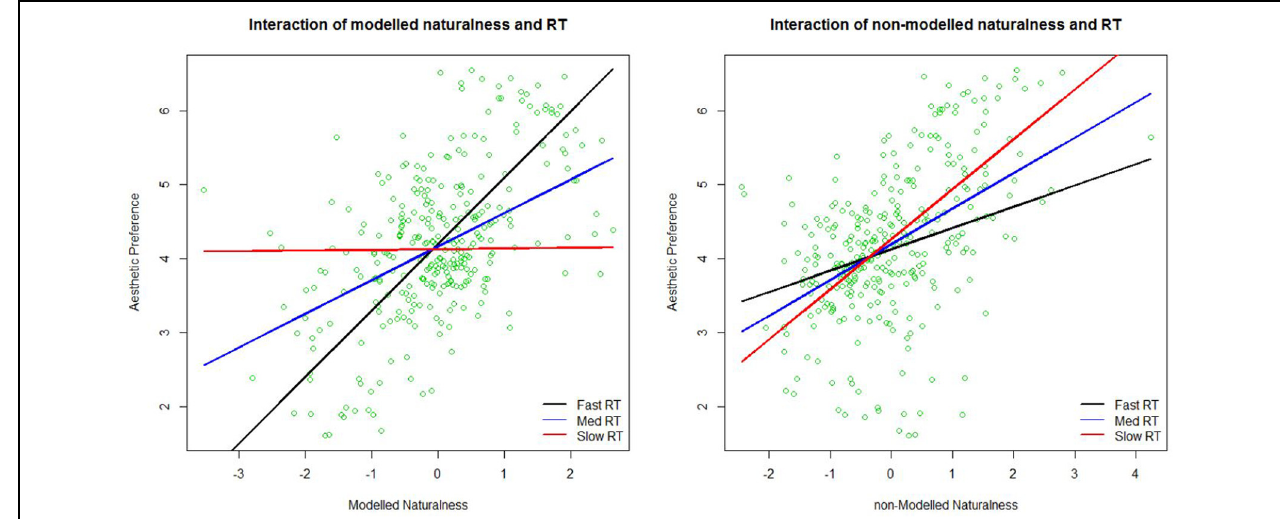
FIGURE 6 | Plots of the interaction of modeled naturalness and the reaction time (RT) to make the preference judgment (left) in predicting preference ratings, and the interaction of non-modeled naturalness and the RT to make the preference judgment (right) in predicting preference.